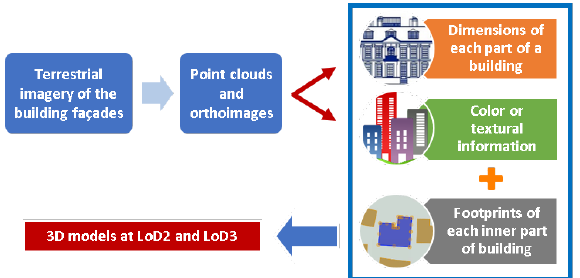
Figure 3. Creation of 3D models at LoD2 and LoD3